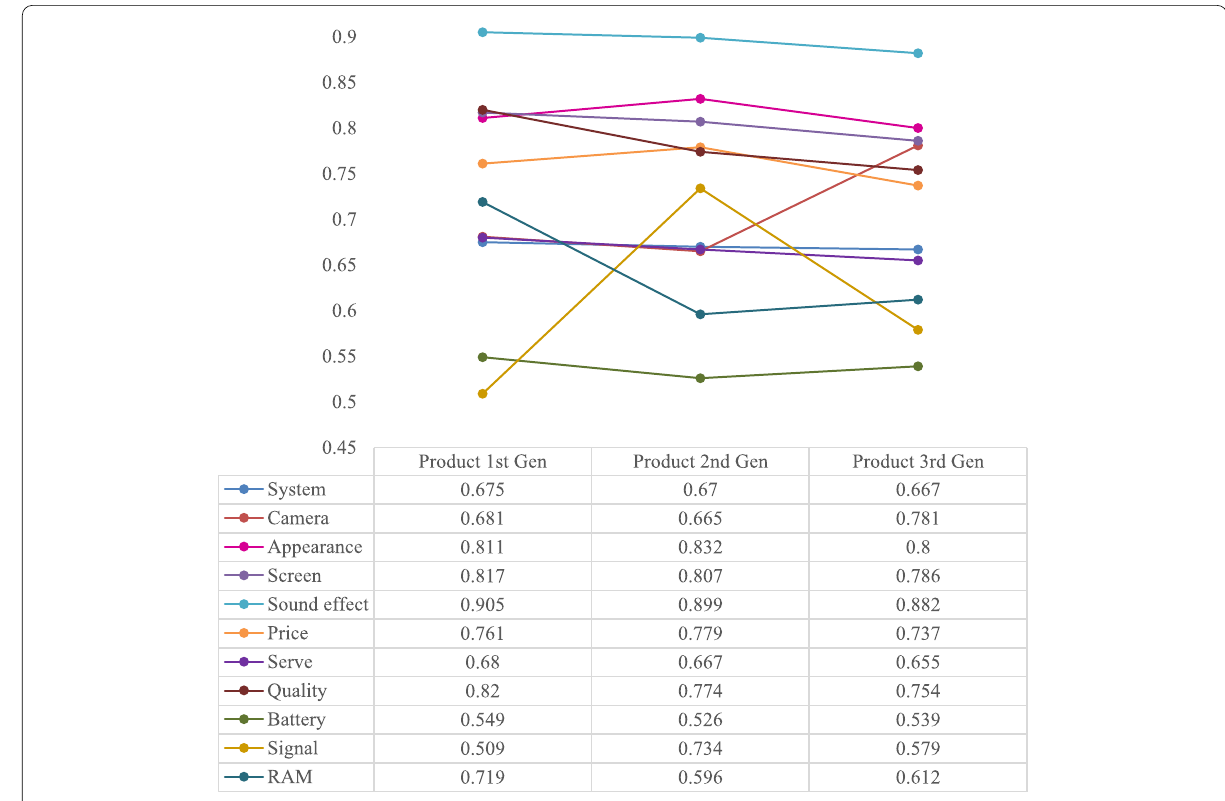
Figure 10 Customer satisfaction for each product attribute of multi-generation